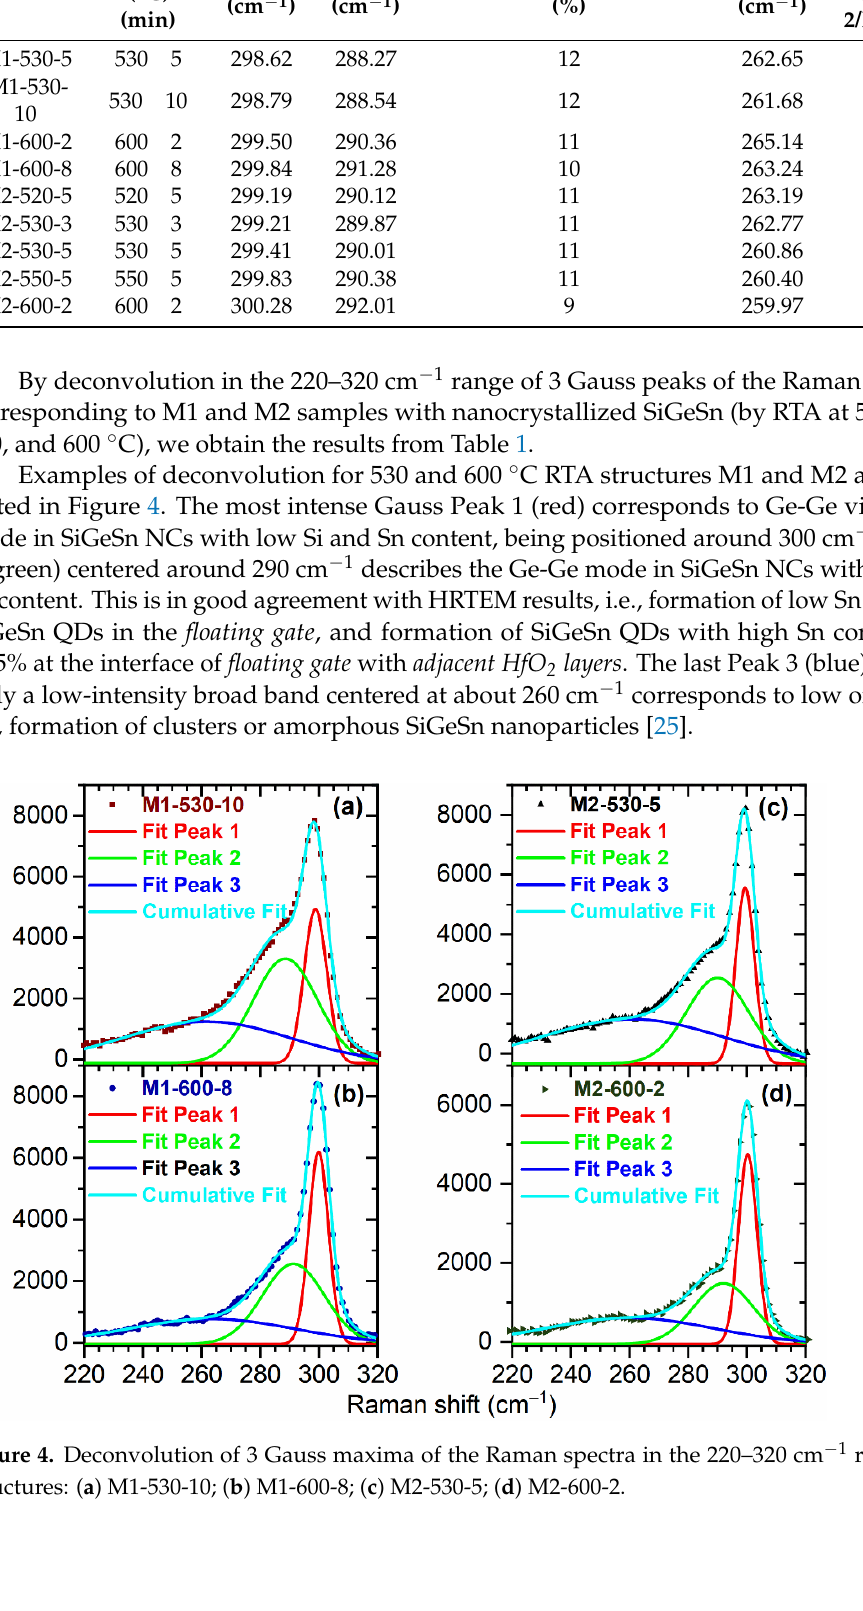
Figure 4. Deconvolution of 3 Gauss maxima of the Raman spectra in the 220–320 cm − 1 range for structures: ( a ) M1-530-10; ( b ) M1-600-8; ( c ) M2-530-5; ( d )